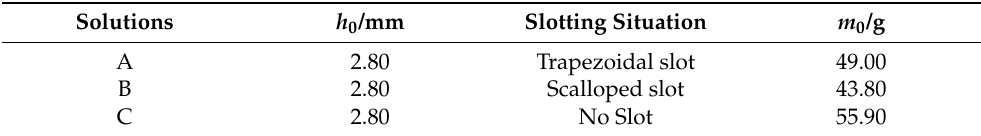
Table 8. Comparison of group characteristics.